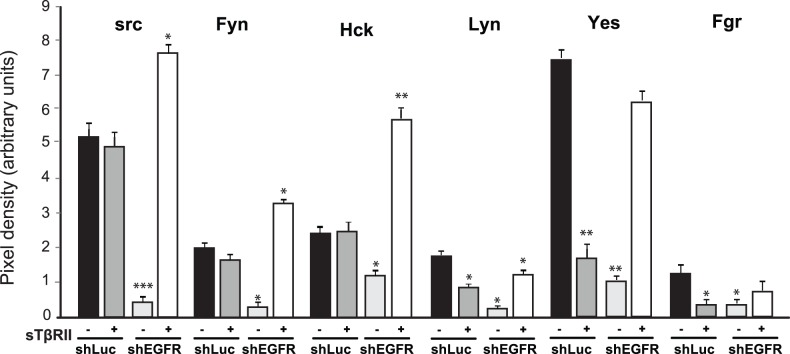
Effects of targeting EGFR and TGF-β pathways on phosphorylation status of src family members.T3M4 cells were infected with shLuc-LV (shLuc), shEGFR-LV (shEGFR), and/or WPT-sTβRII (sTβRII) as indicated. Cell lysates were then analyzed with a phospho-kinase antibody array to assess the phosphorylation status of the indicated src family members. Results were quantified as described in Methods. Data are the means ± SEM of triplicate determinations from three independent experiments. *p<0.05, **p<0.01, and ***p<0.001 when compared with control.